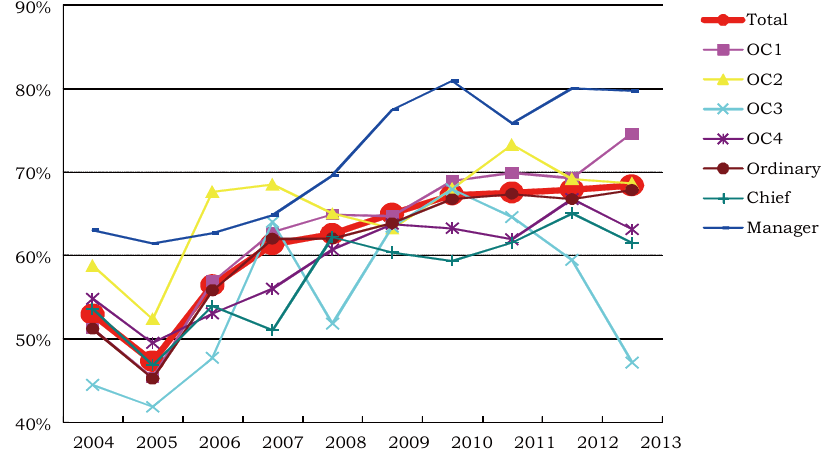
Figure 1. Annual transitions in job satisfaction ratio of Survey X